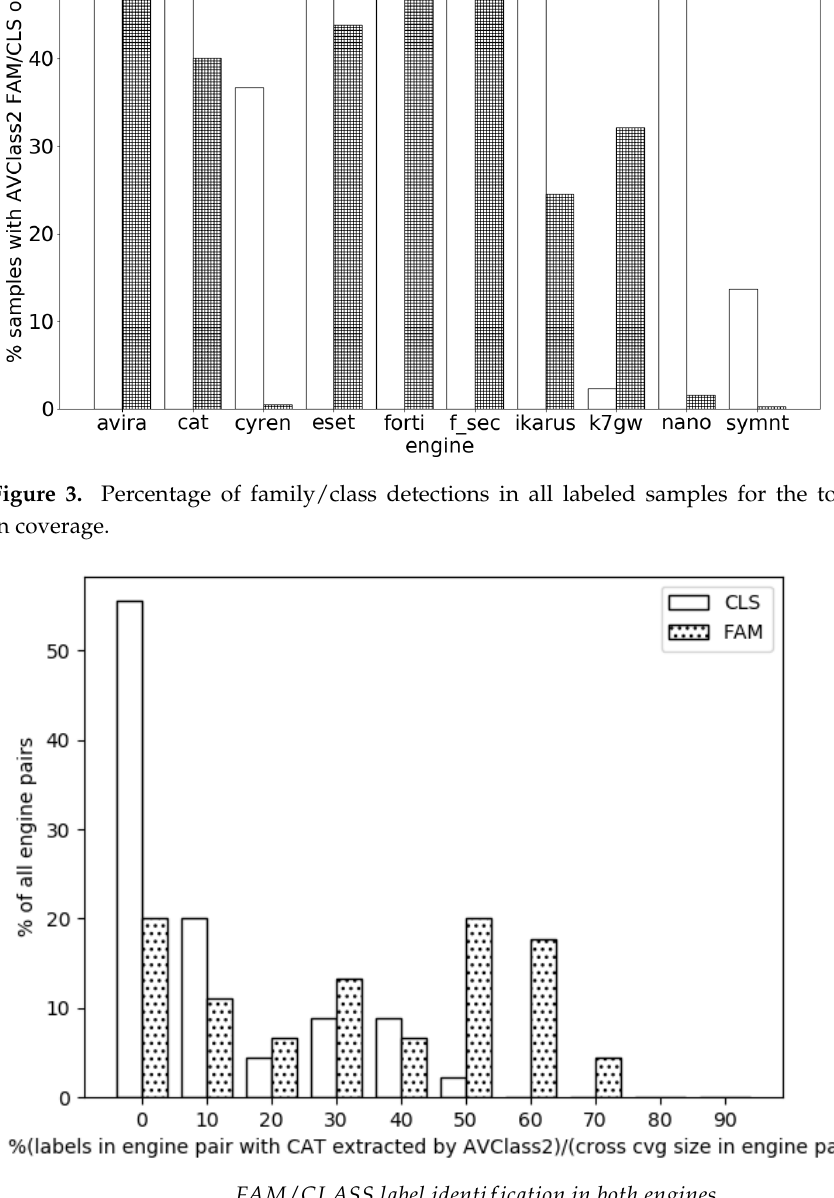
FAM / CLASS label identification in both engines Figure 4. Histogram for after using AVCLASS2 total cross coverage for engine pairs ( A2 ) to extract FAM/CLASS. max( A2 FAM) = 77% , max( A2 CLASS) = 55% . CAT here refers to category and not